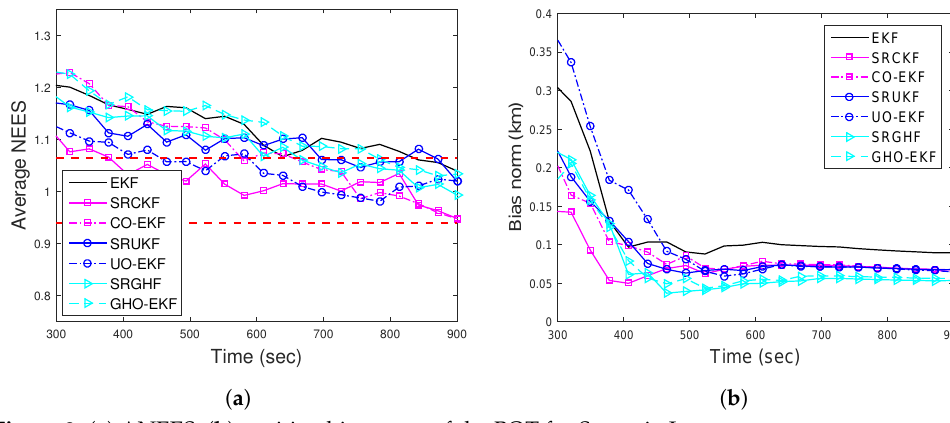
Figure 3. ( a ) ANEES; ( b ) position bias norm of the BOT for Scenario I. ANEES metrics are calculated for various adaptive filters for e T ∈ { 200 m, 500 m } . For e T = 500 m, none of the filters’ ANEES is inside the concentration region. In Figure 6a,